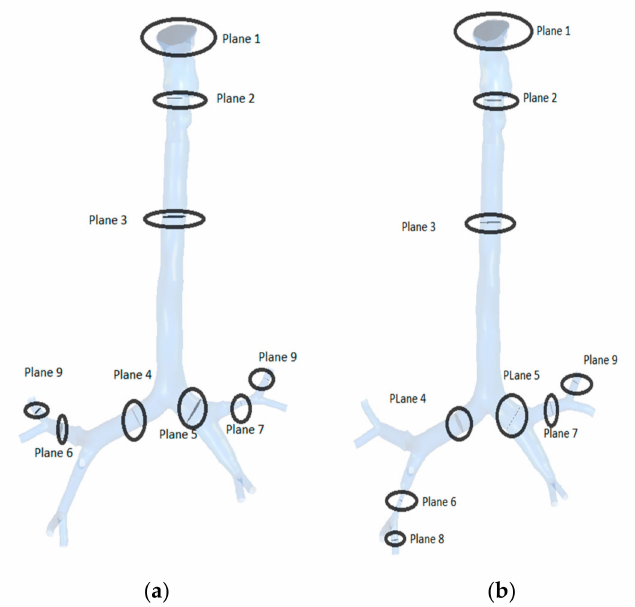
Figure 7. Selected planes for di ff erent lung stenosis models: ( a ) stenosis of the right lung and ( b ) stenosis of the left